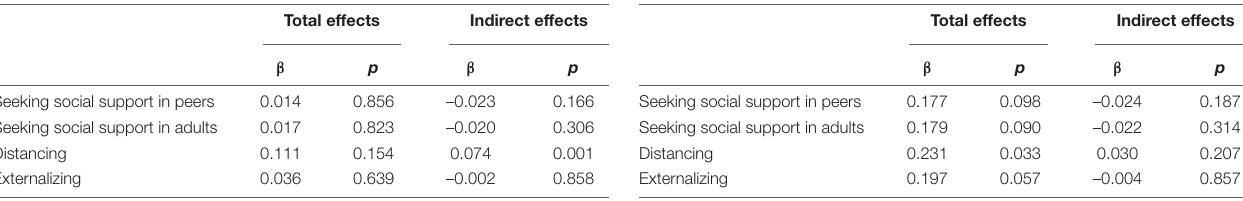
TABLE 3 | Total and indirect effects for relations between (b) anxiety-related behaviors, news avoidance and reactive coping